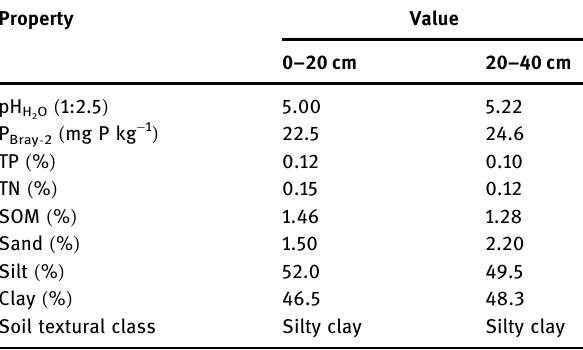
Table 1: Initial soil quality before the experiment